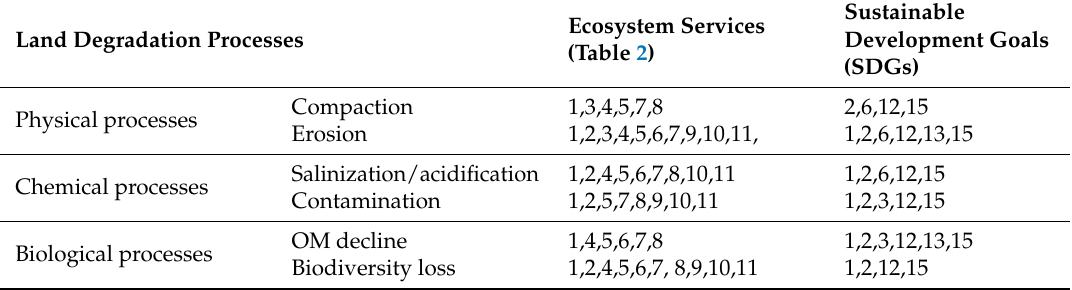
Table 1. Links between degradation processes, ecosystem services, and sustainable development goals.